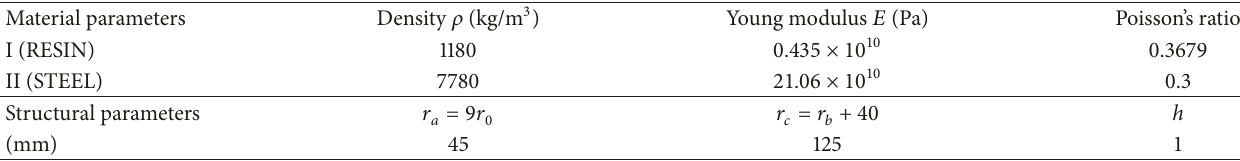
Table 1: Material and structural parameters.